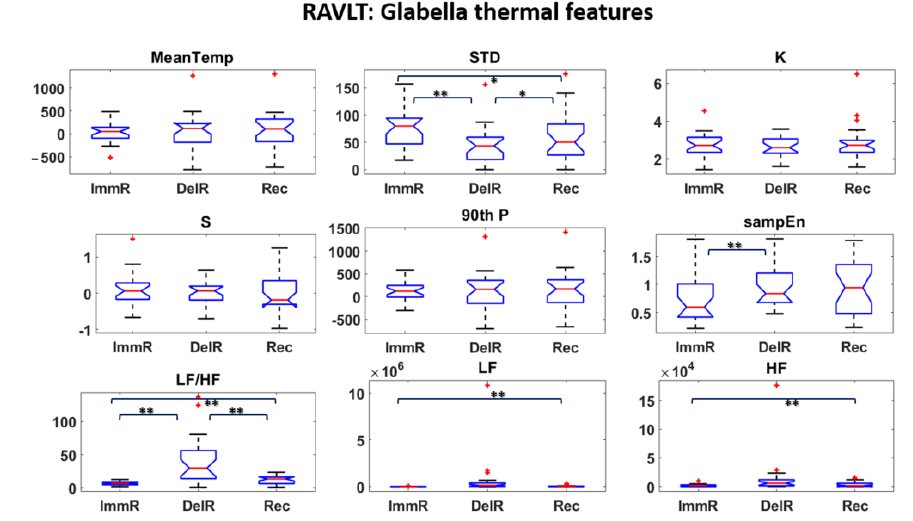
features described in section 3.3.